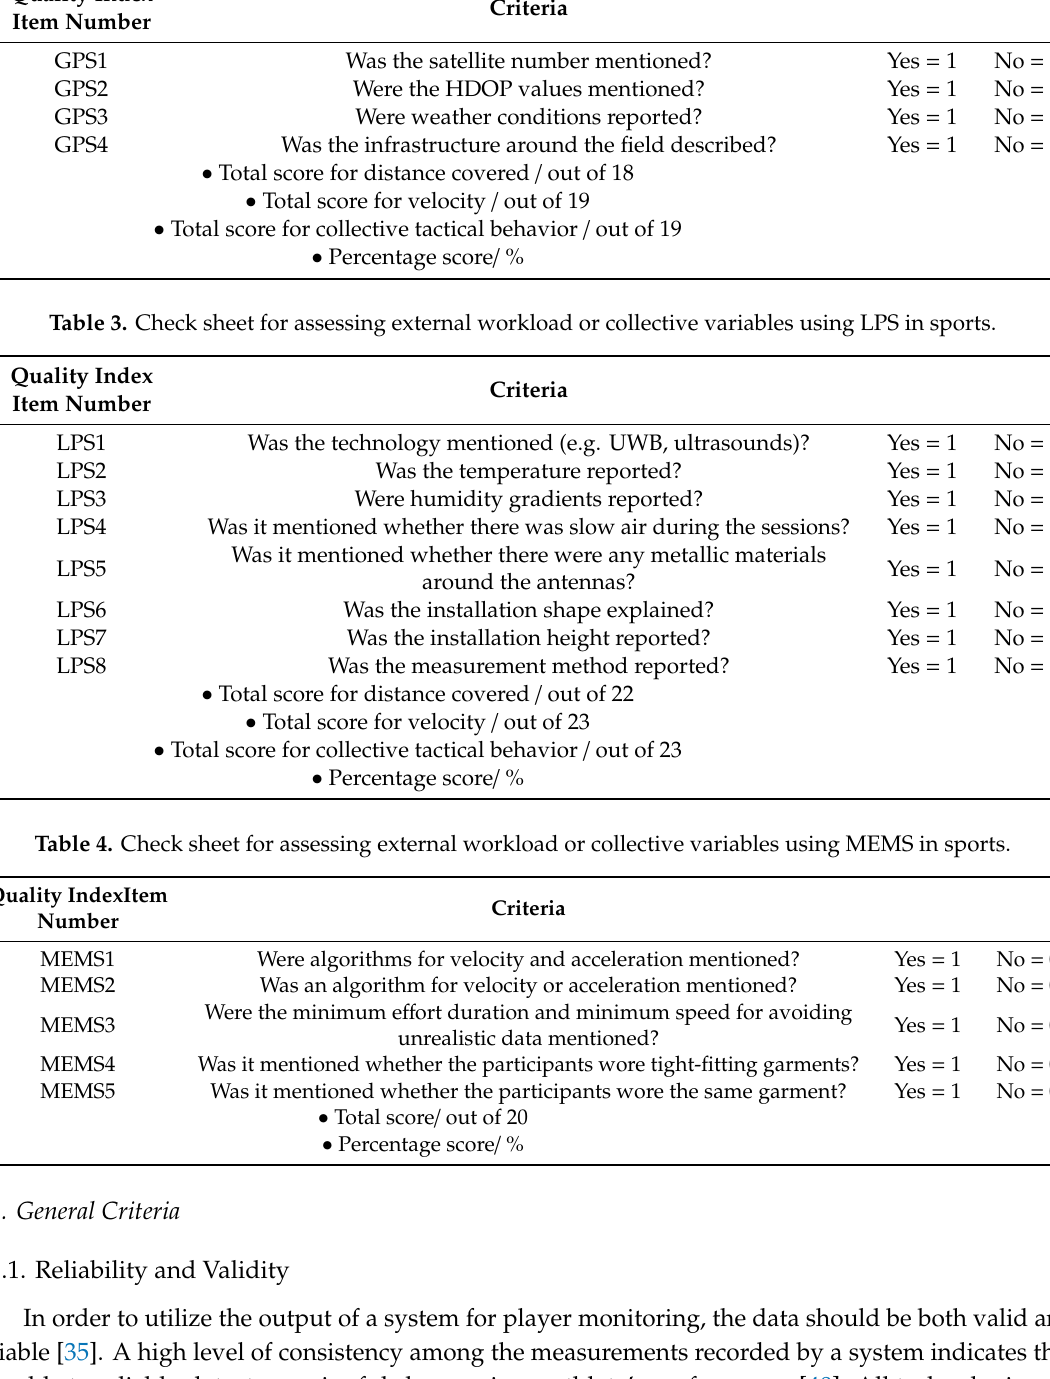
Table 2. Check sheet for assessing external workload or collective variables using GPS / GNSS in sports. Quality Index